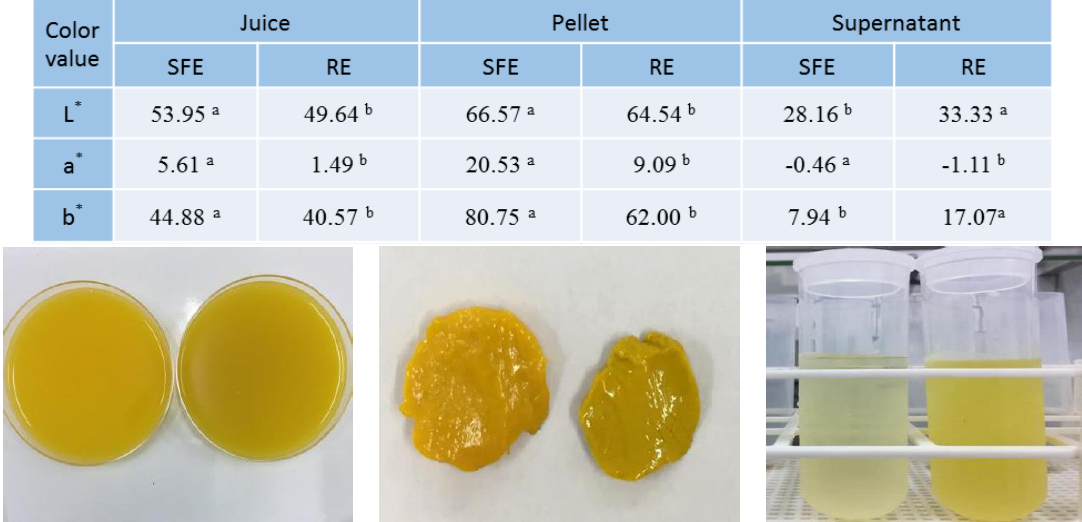
Figure 1. Color values ( n = 3) and visual images of juice, pellet, and supernatant of “Valencia” orange juice processed using shear force extractor (SFE) and reamer extractor (RE) types. Color values followed by a letter indicate significant differences between SFE and RE ( p = 0.05) within each sample type.